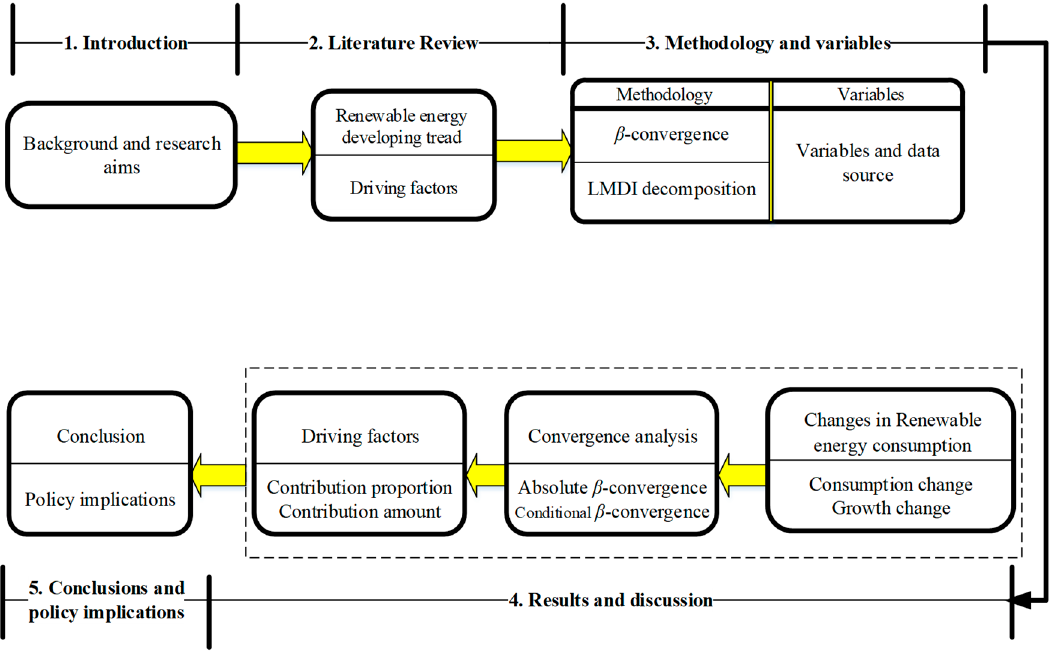
Figure 2. Framework of this study.